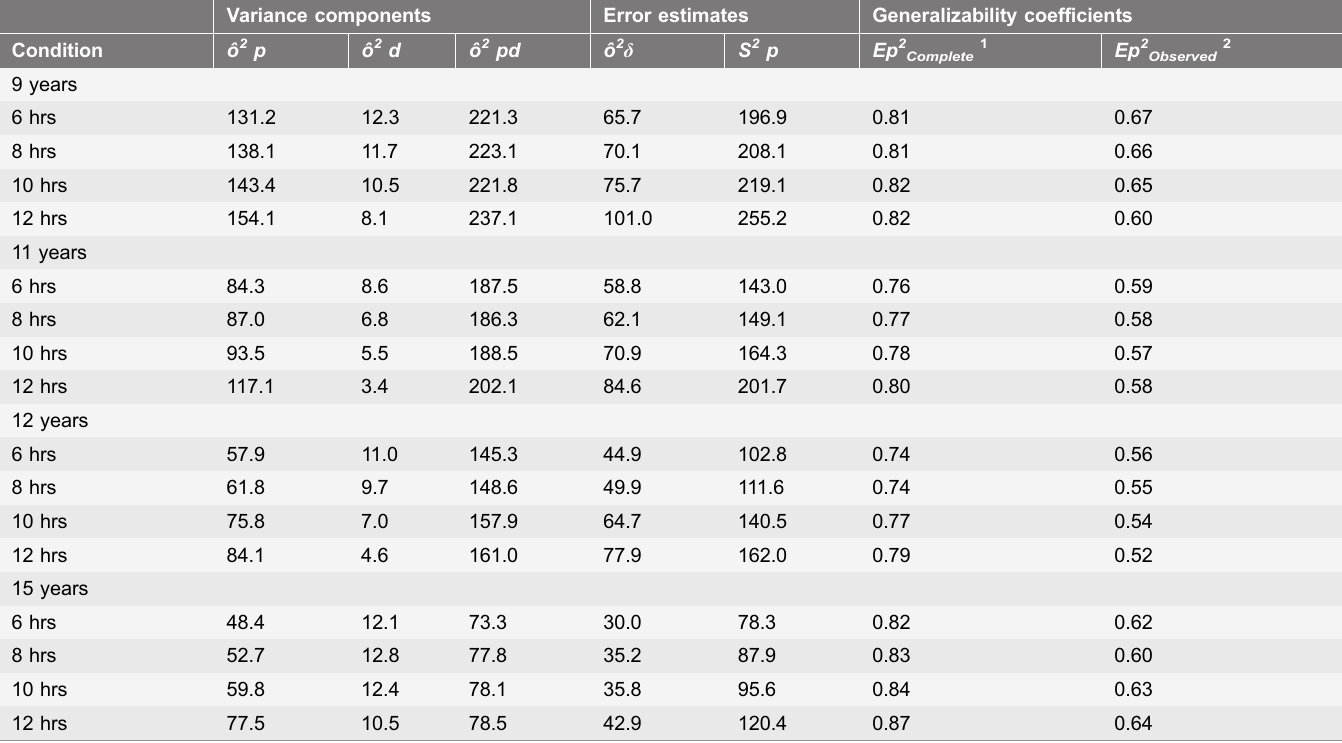
Table 3. Variance components, error estimates and generalizability coefficients of MVPA by age and wear time criteria. Variance